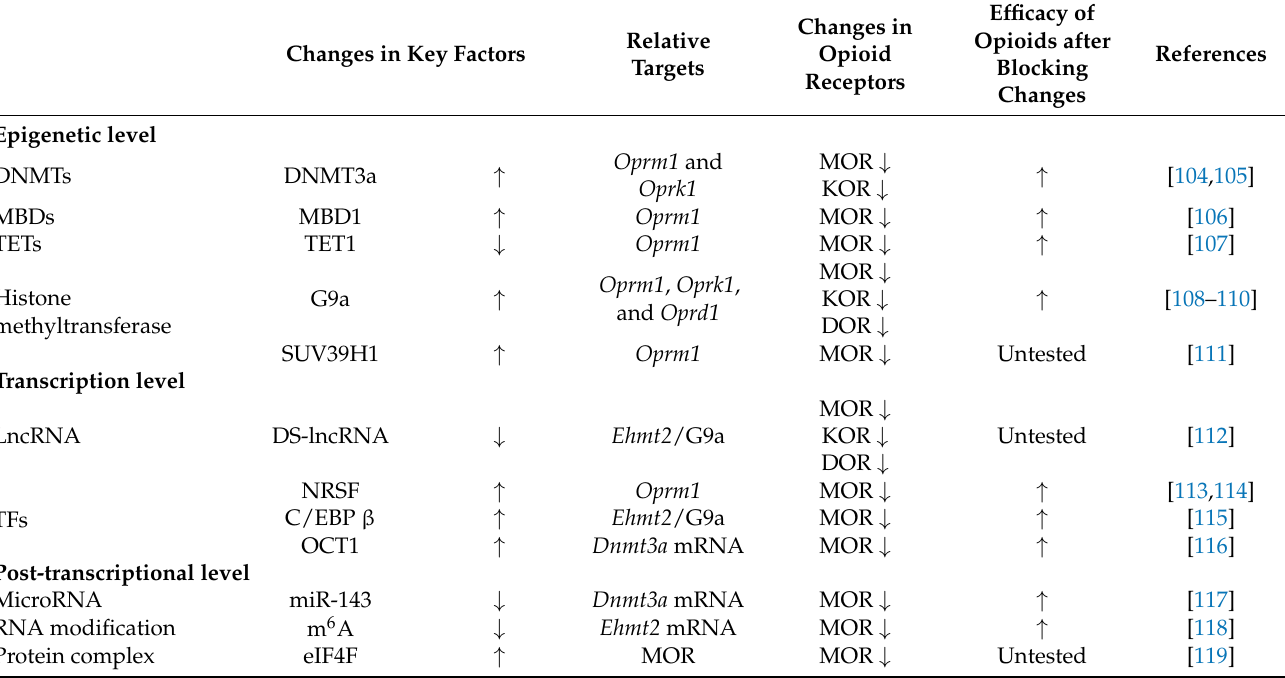
Table 2. Mechanisms of opioid receptor downregulation in DRG following peripheral nerve